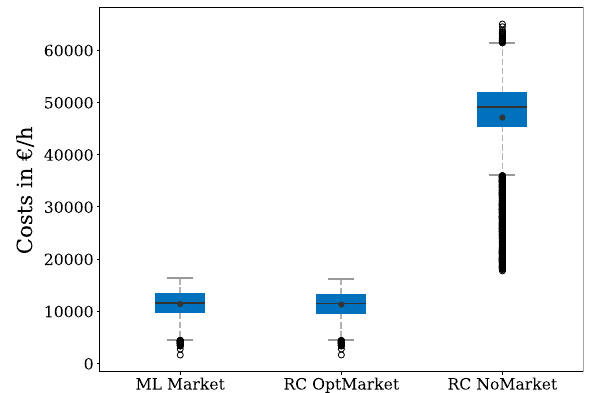
Fig. 7 Total economic costs of the reactive power provision (Average total costs: Multi-level market 11401.33 € , RC OptMarket 11302.60 € /h, RC NoMarket 47104.03 €